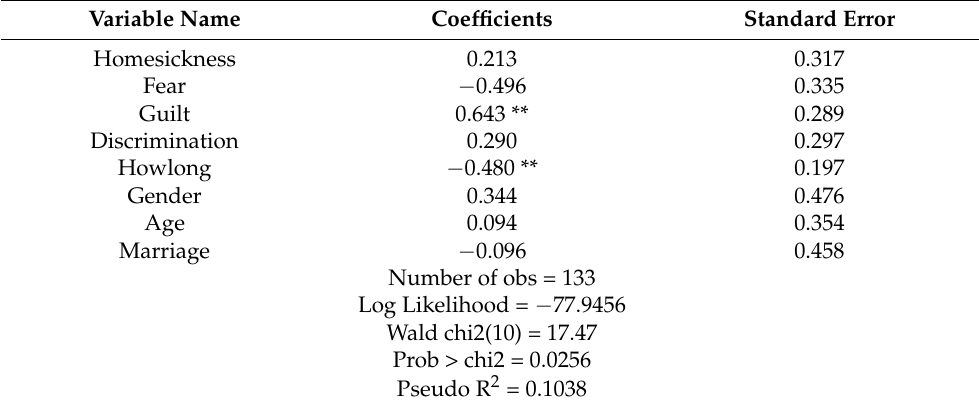
Table 5. Logit model for whether students would have preferred to return to their home